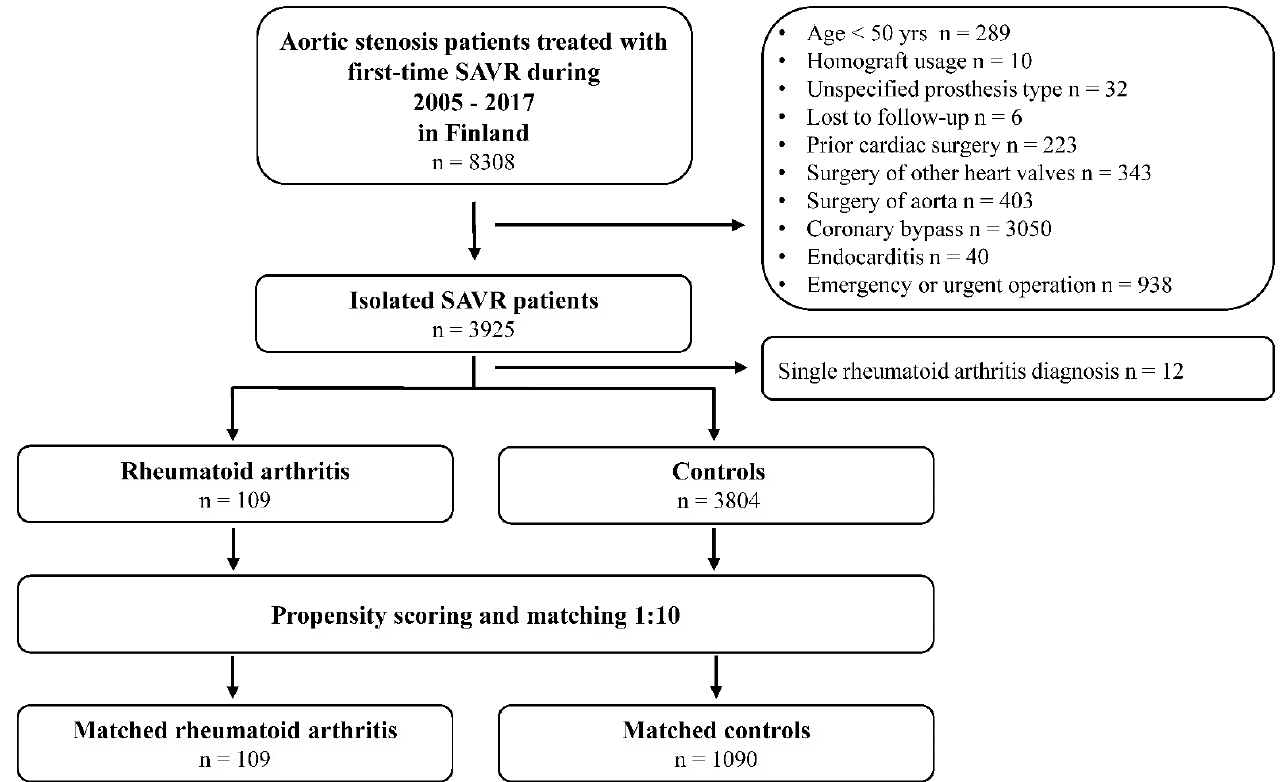
Figure 1. Study flow chart. SAVR = Surgical aortic valve replacement.